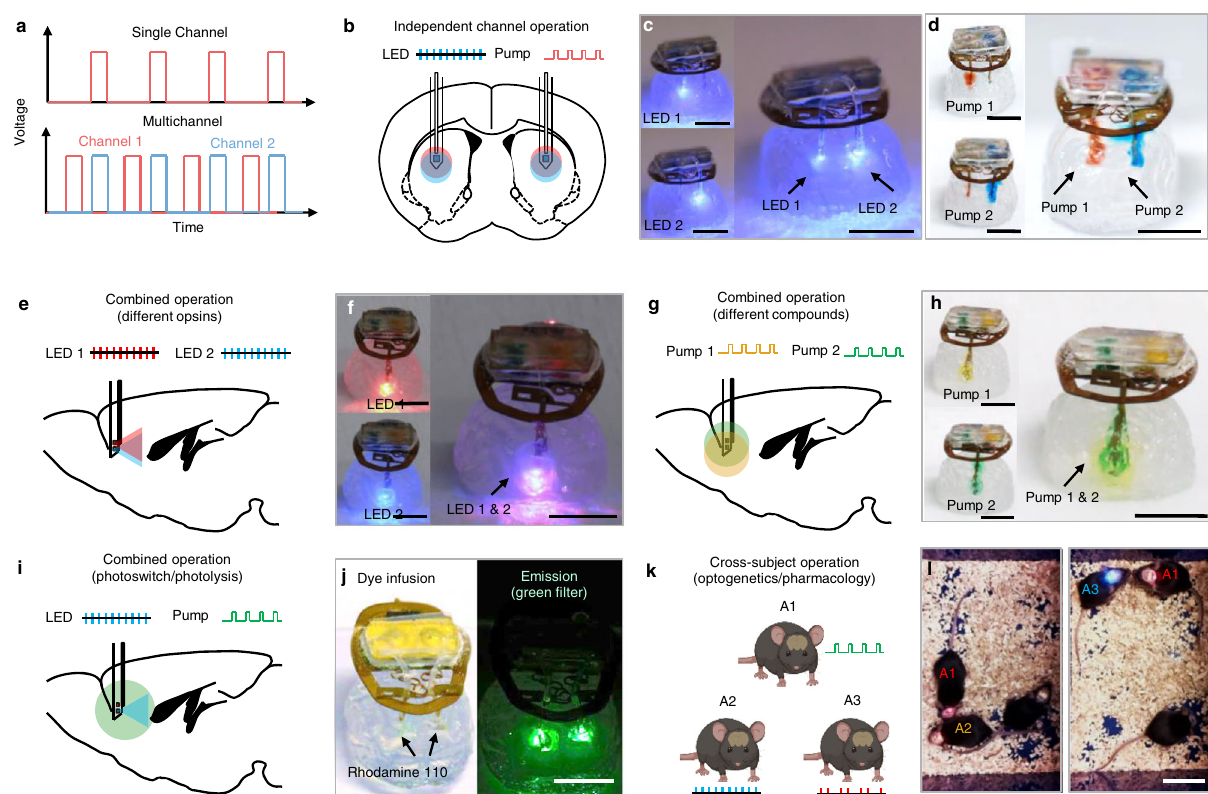
Fig. 2 | NFC-enabled dynamically programmable and selective operations for both bilateral and unilateral bi-channel devices. a Waveforms associated with the single mode and out of phase dual mode of operation. b Illustration of inde- pendentchanneloperationofasingle µ -ILEDor µ -pumpordual µ -ILEDsor µ -pumps in a bilateral opto fl uidic device. c , d Photographs that demonstrate bilateral opto- fl uidicdevicesoperated insingle modeanddualmodeforbothopticalstimulation (4Hz, 50% duty cycle) and fl uidic delivery(4Hz, 10% duty cycle). Scale bar:0.5cm. e Illustration of combined operation of two µ -ILEDs with different wavelengths for different opsins stimulation at a single location. f Photograph that demonstrates unilateral bi-channel opto fl uidic devices with single/dual two-wavelength optical stimulation (4Hz, 100% duty cycle).Scale bar: 0.5cm. g Illustration of combined operation of two individual µ -pumps for various compounds infusions at a single